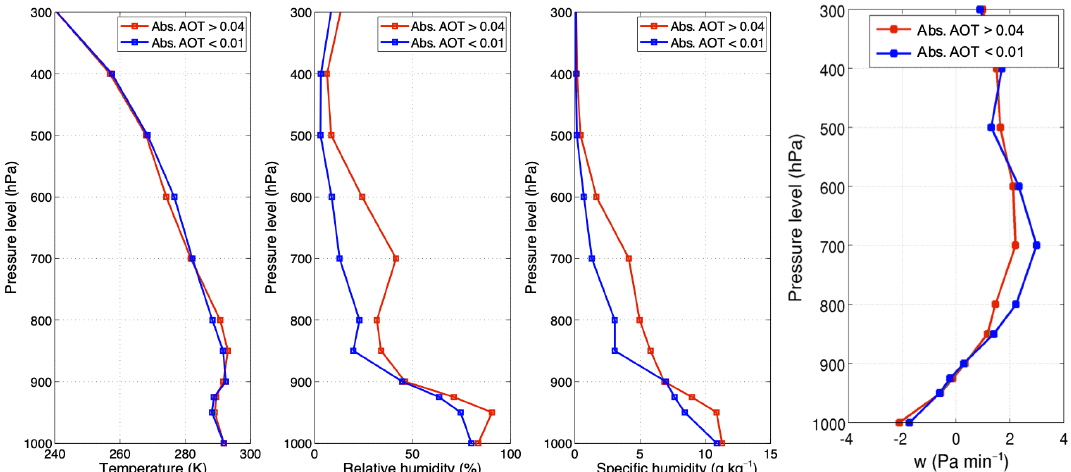
Figure 8. Mean values of (a) temperature profile and (b) relative humidity profile, (c) specific humidity profile and (d) atmospheric subsi- dence at noon, w (downwelling wind, Pamin − 1 ), within the sample region, from June to August 2008 selected for two situations: POLDER absorption AOT 865nm smaller than 0.01 (red lines, mainly June–July 2008) and POLDER absorption AOT 865nm larger than 0.04 (blue lines, mainly August 2008).